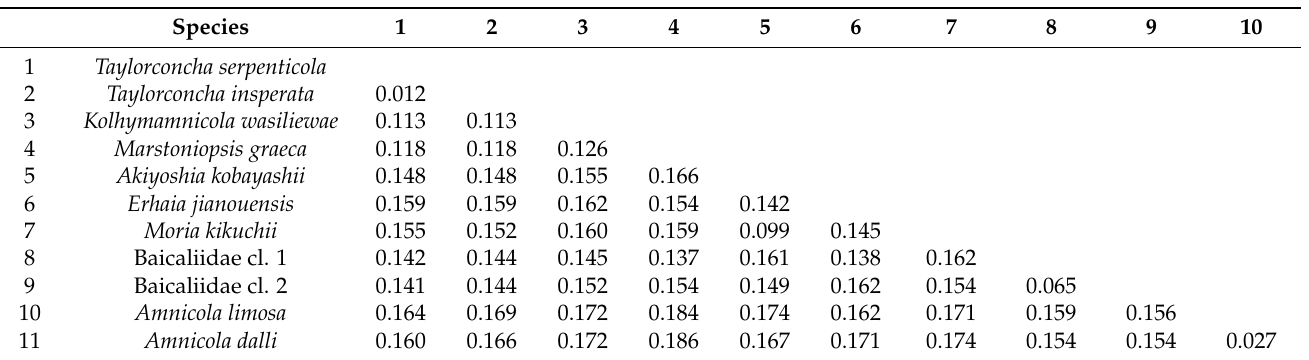
Table 5. Pairwise uncorrected p -distances of COI sequences between different species of Amnicolidae and